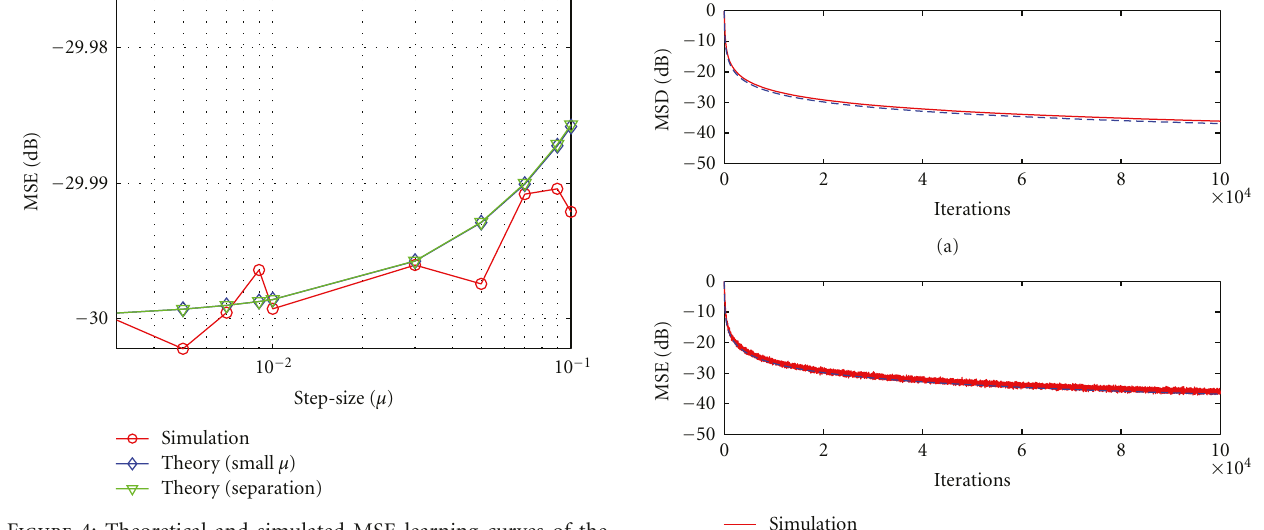
Figure 4: Theoretical and simulated MSE learning curves of the SRLMF algorithm using Gaussian regressors with an eigenvalue spread = 5 without shift structure with SNR = 30 dB.